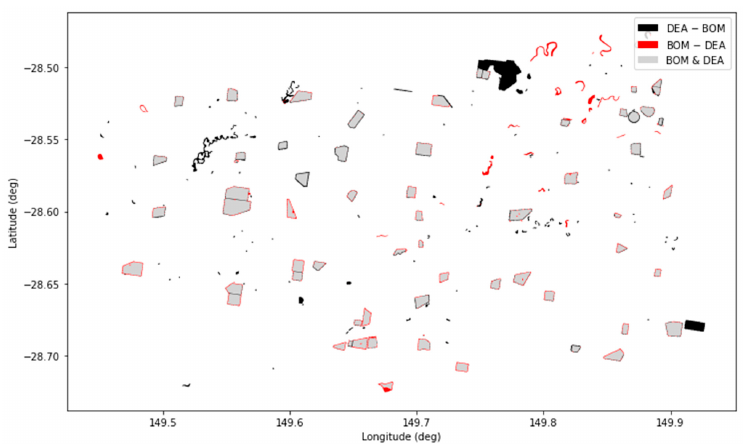
Figure 5. Difference and intersection between DEA Waterbodies and Geofabric in the Moree test area, dominated by constructed farm storages. Differences have been smoothed and buffered by 10 m to aid visibility. The Moree comparison shows that almost all Geofabric waterbodies are also in- cluded in DEA Waterbodies, with only minor differences along the edge of the polygon. These minor differences are due to the pixel grid of Landsat compared to the smooth and